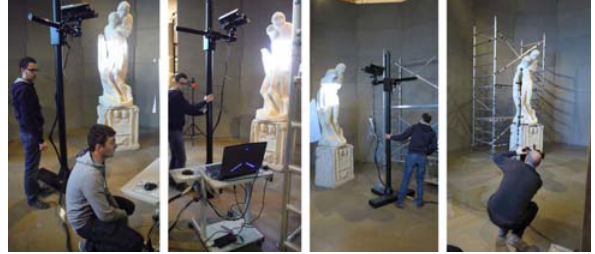
Figure 3. Scanner survey using Chronos 3D